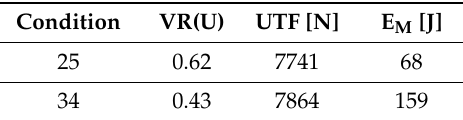
Table 8. Joint performance comparison.